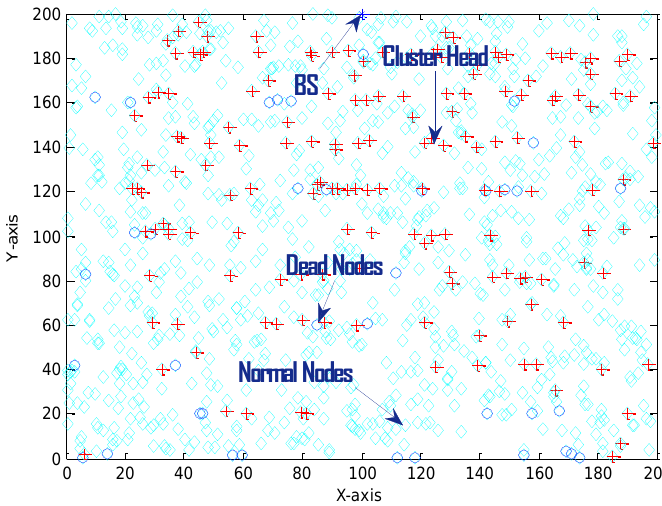
Figure 2. Smulation after 200 rounds of data transmission.